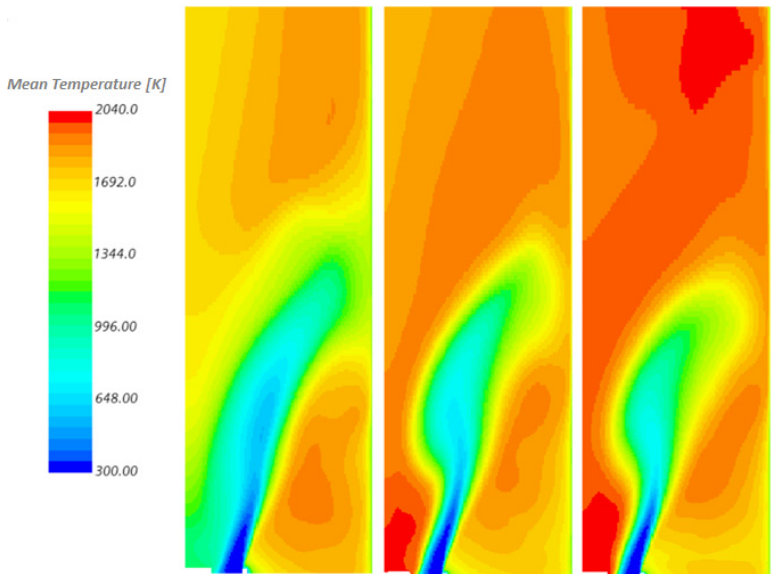
Figure 7. Mean temperature. ( Left ) 20/80; ( Centre ) 40/60; ( Right ) 60/40 (vol%) methane/ammonia blends under stoichiometric conditions.